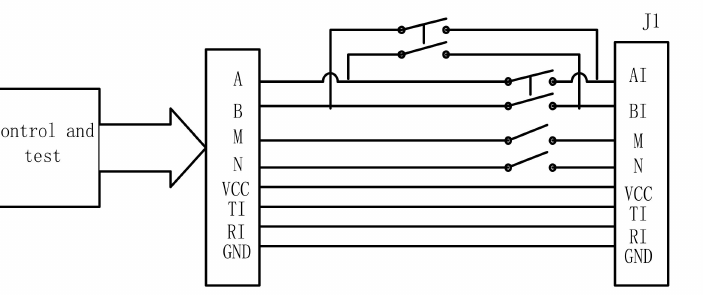
Figure 2. Power supply interface schematic for ERT in ESD, designed by Zheng Cai-Jun [23].